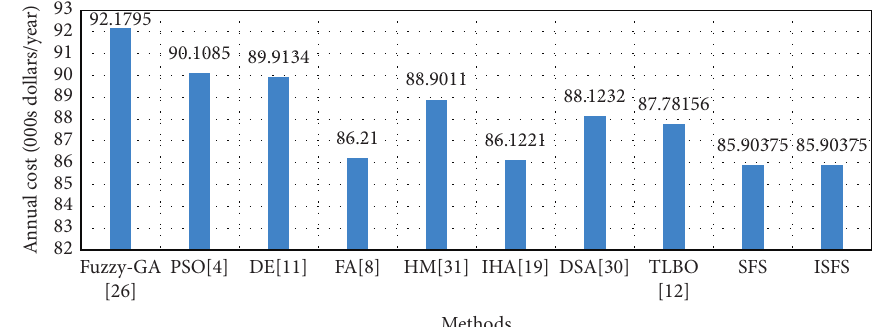
Figure 10: A schematic view of comparison of minimum annual costs obtained by different methods for 69-bus network.